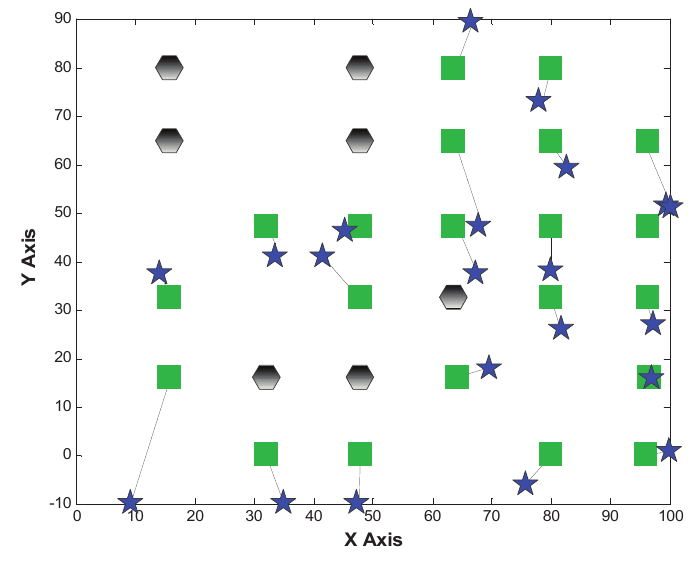
Figure 14. Localization results of MDS-SSLM. Table 2. Error statistics for a non-regular